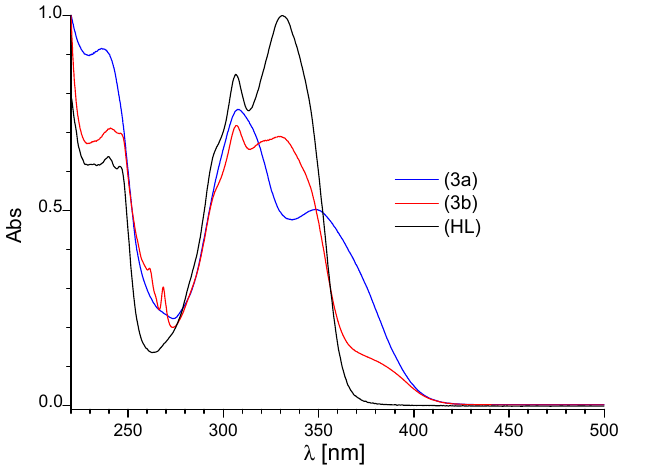
Figure 5. The absorption spectra of HL , (Tb group A) 3a and (Tb group B) 3b in acetonitrile solution; c = 2 × 10 − 5 M.